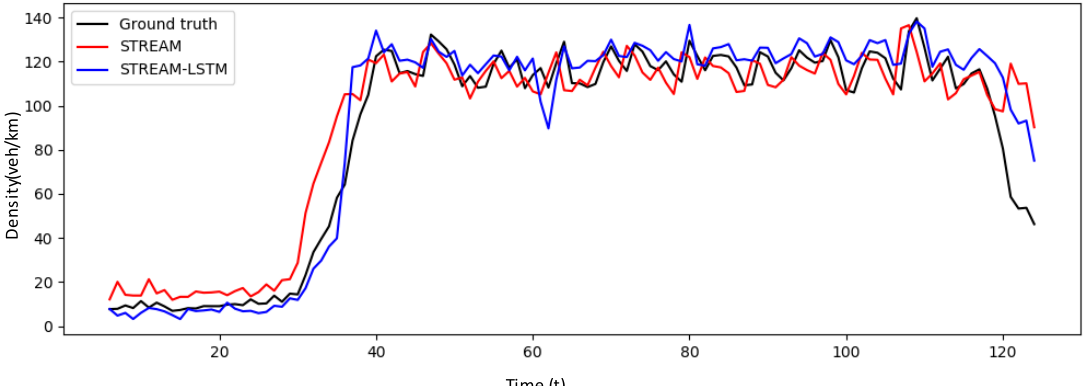
Figure 8. Overall comparisons between the proposed STREAM-LSTM and STREAM.